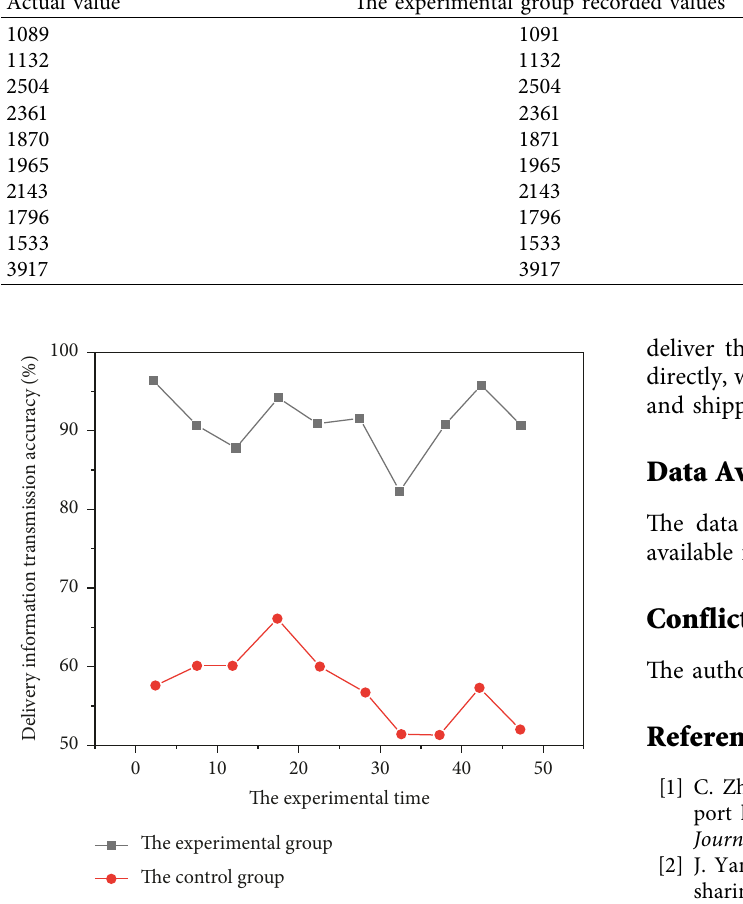
Figure 4: The accuracy of logistics distribution information